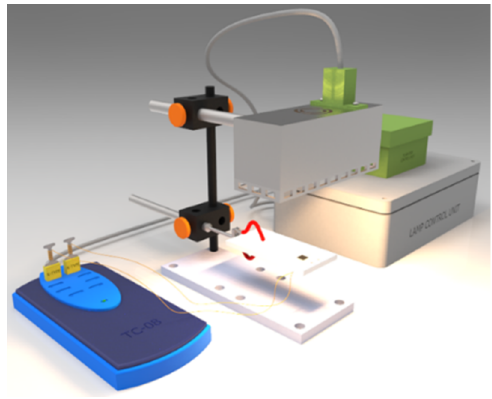
Figure 1. sintering setup. Left : Picolog thermocouple logger, Center : Near-infrared (NIR) lamp located above a Teflon (PTFE) substrate holder with two embedded thermocouples, Right : Control boxes with NI6008 USB IO device.